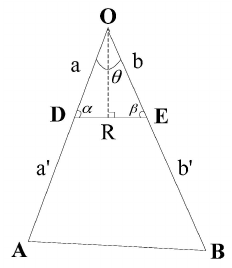
Figure A1. Diagram of